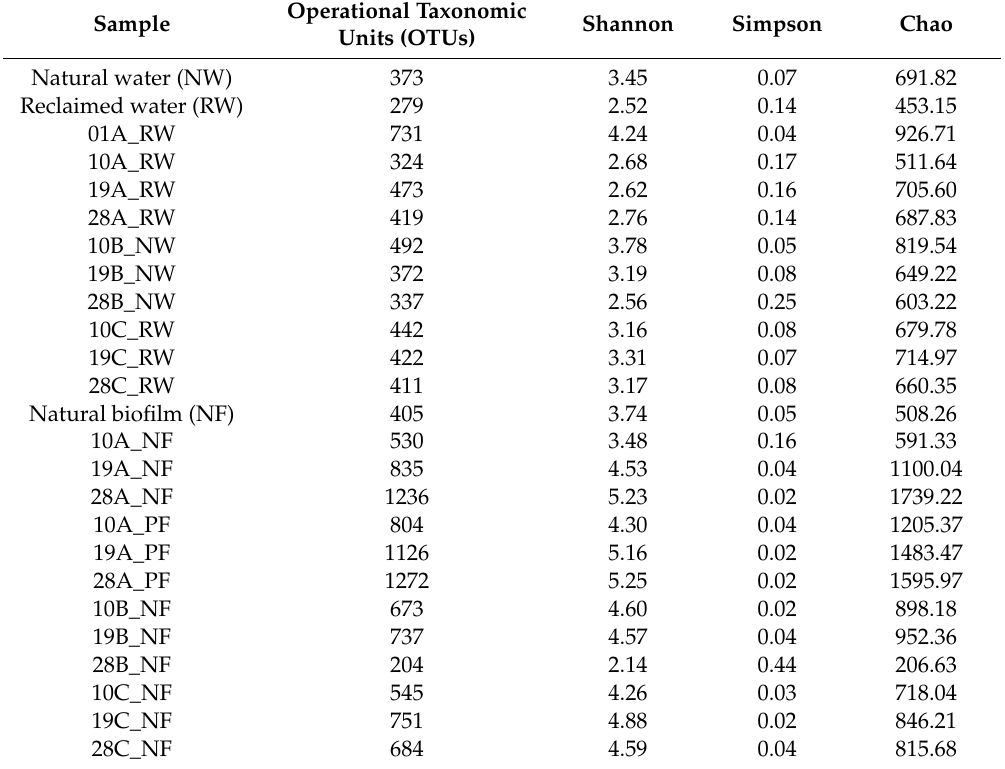
Table 2. Diversity and richness estimated by Shannon, Simpson and Chao